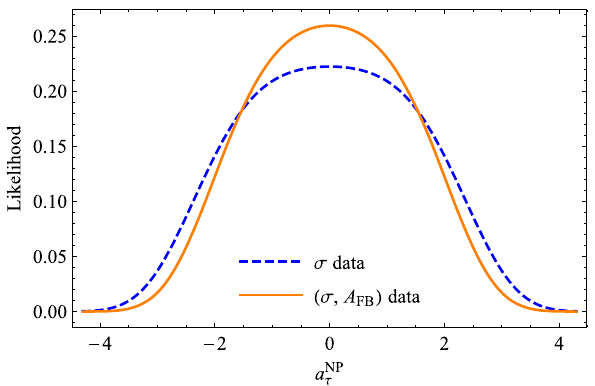
Fig. 3 The likelihood function of the new physics contribution to the tau anomalous magnetic moment, L ( a NP τ ) . For the blue dashed line, the LEP-II data for only the cross-section are considered. For the orange solid line, the LEP-II data for both the cross section and the forward- backward asymmetry are